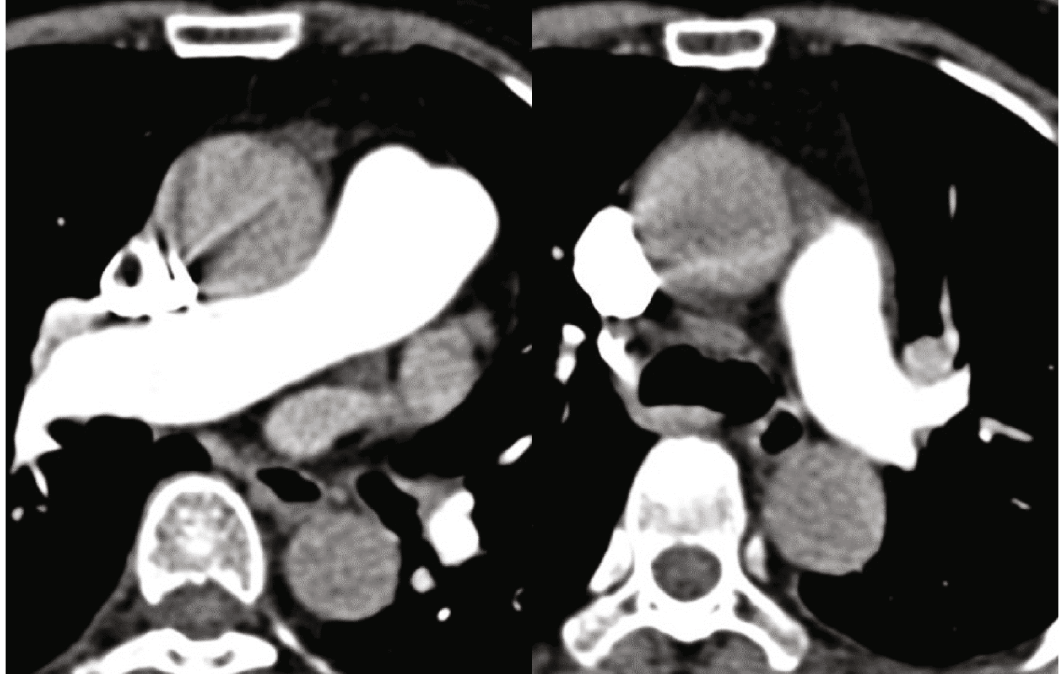
Figure 3: The spiral computed tomography angiogram obtained with highly concentrated contrast material and high fl ow technique showed that the contrast material fi lled the right pulmonary arterial system, and there was no embolus as previously documented in Figure